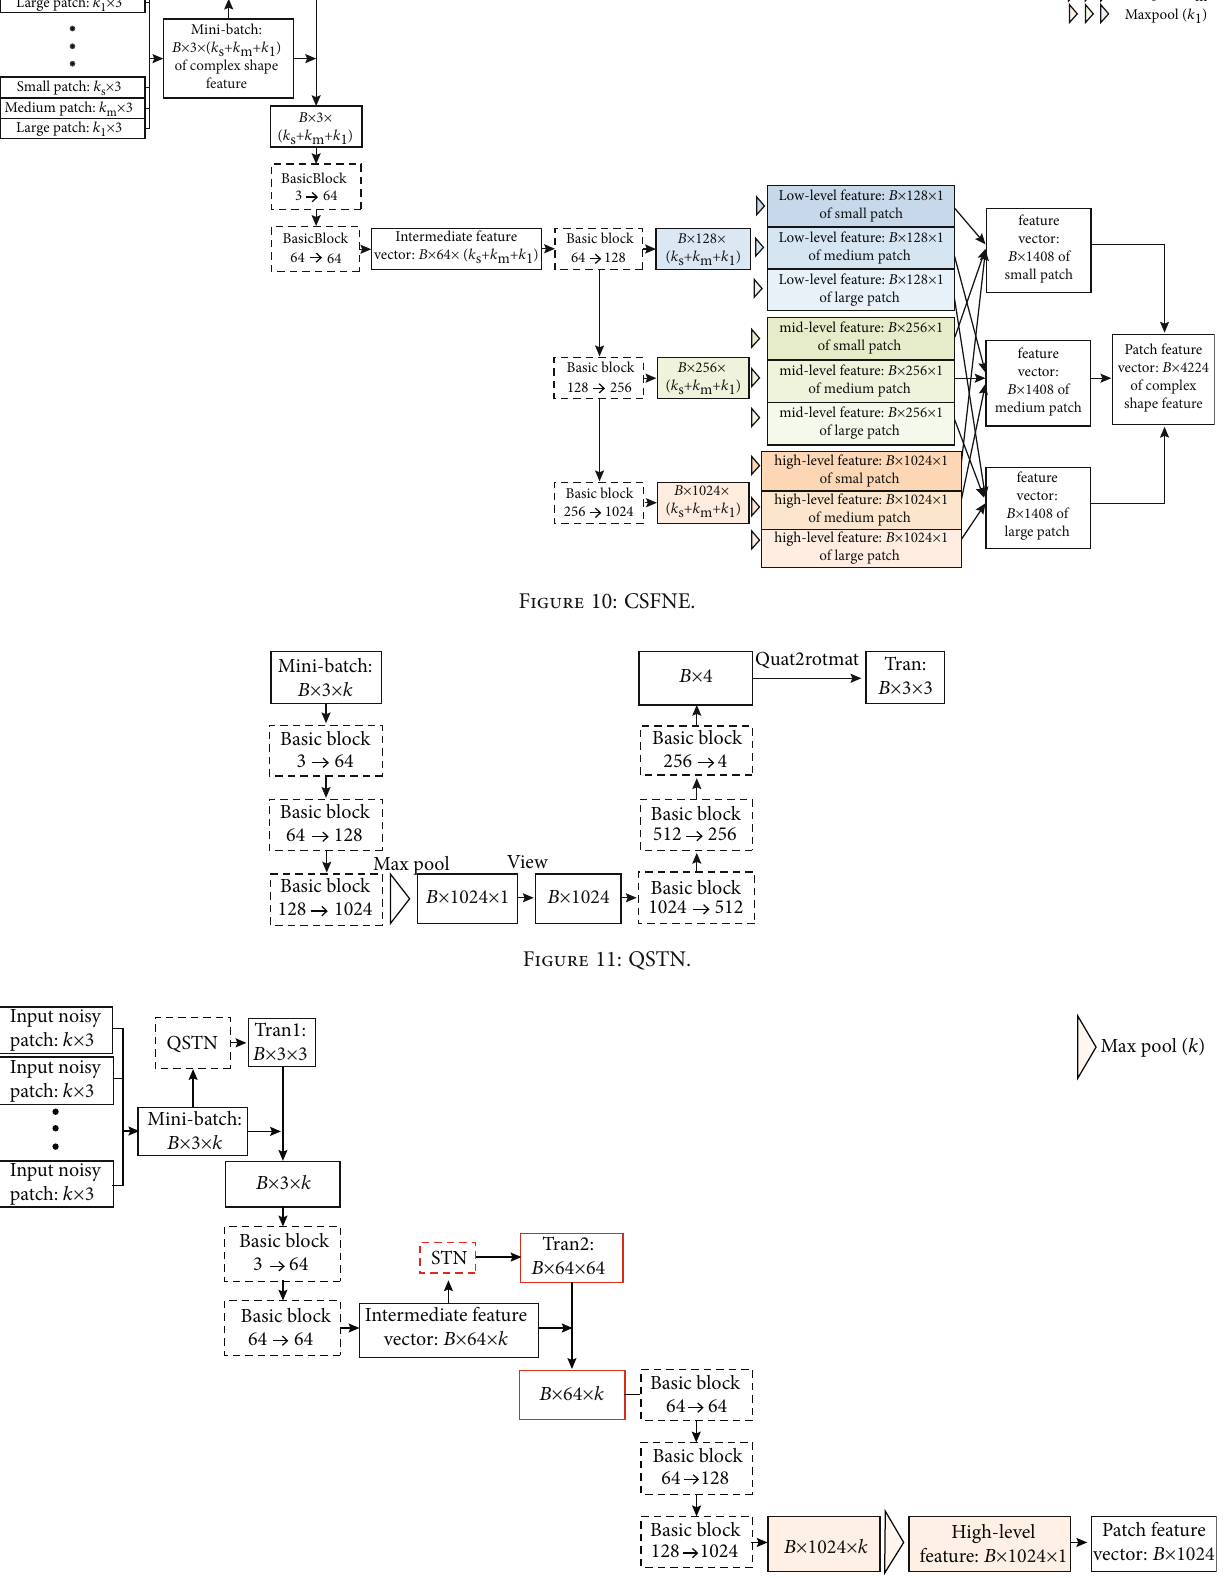
Figure 10: CSFNE.